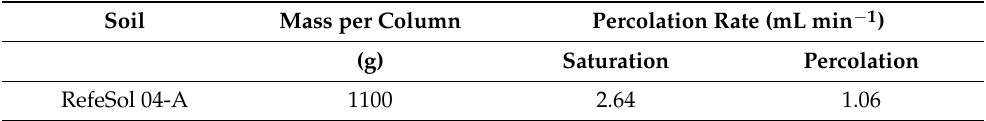
Table 2. Mass of soil per soil column and percolation rates for saturation and percolation.